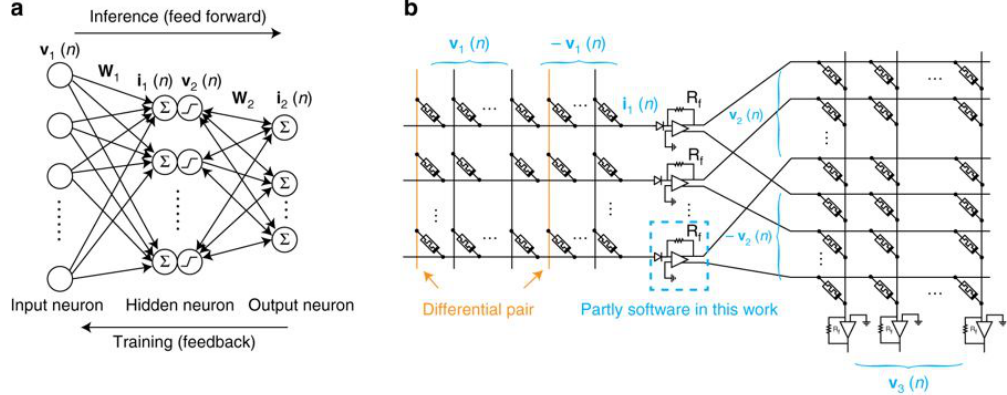
Figure 5. Memristors used for synaptic weights in artificial neural networks (ANNs), reproduced with permission from Figure 2 of [57]. Subfigure ( a ): memristive neural network. In Subfigure ( b ) we introduce the crossbar implementation of the memory using